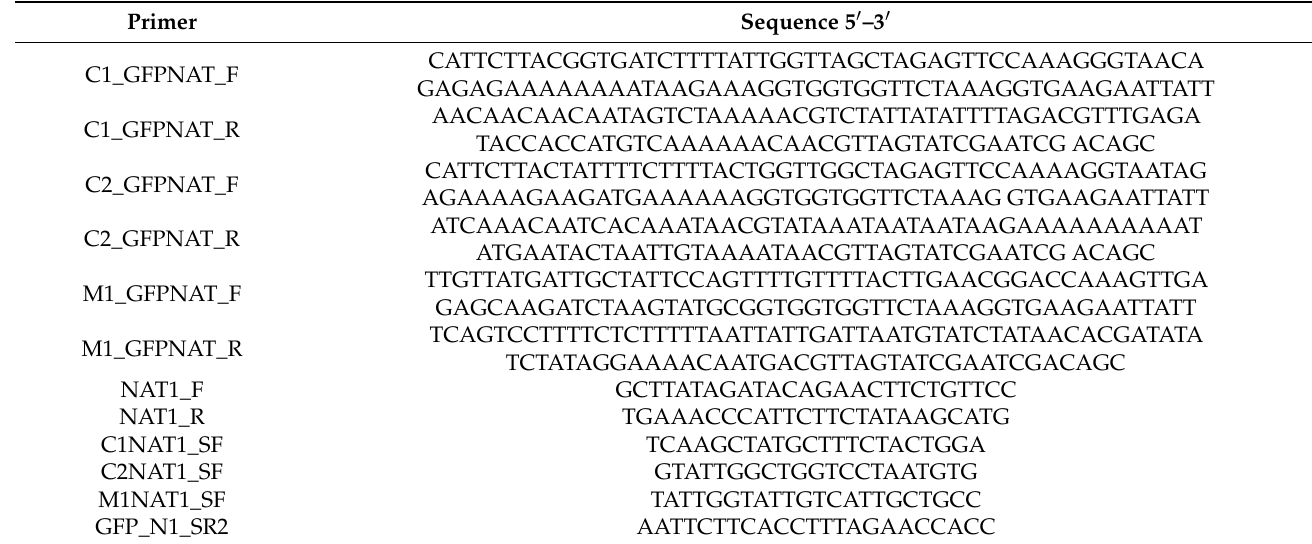
Table 2. Primers Used in This